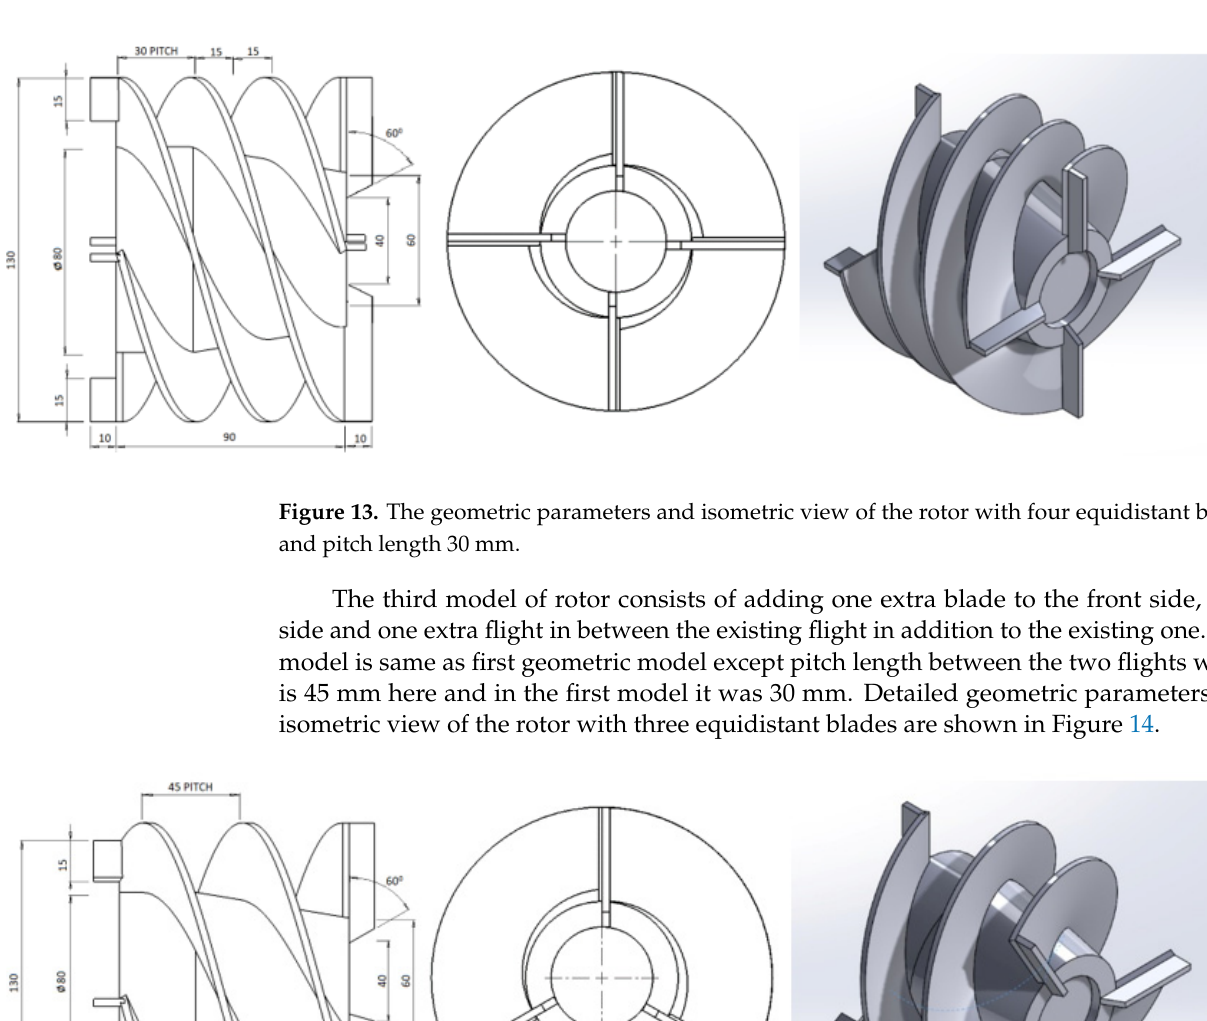
Figure 15. The geometric parameters and isometric view of the rotor with four equidistant blades and pitch length 45 mm. 4.2.1. Variation of Velocity Magnitude As seen from the previous section, the realizable K- ϵ model was found to be the most appropriate model for simulating the flow characteristic in the pump. Following this, an- other study on the effect of geometric modification on the pump performance was con- ducted using the identified appropriate turbulence model (realizable K- ϵ ). The CFD anal- ysis simulates the internal flow inside the pump and aids in understanding of more com- plex phenomena and its evaluation. For better understanding of the flow behaviour, the velocity distribution in the pump at two different flow rates (4 and 6 m 3 /h) is shown in Figure 16a–e. The asymmetry introduced by the casing and the rotor section of the pump greatly affects the flow in the pump. While it gives a good indication of the flow inside the pump, a strong recirculation zone appears at the rotor and casing close to the rotor exit. The relative velocity was found to be smaller at the eye of the rotor in all cases.